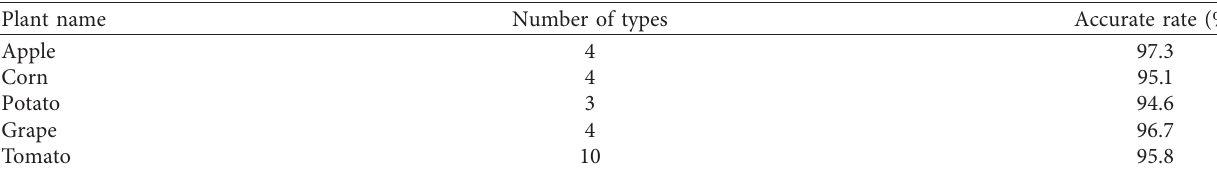
Table 3: Accuracy rates of different subsets.